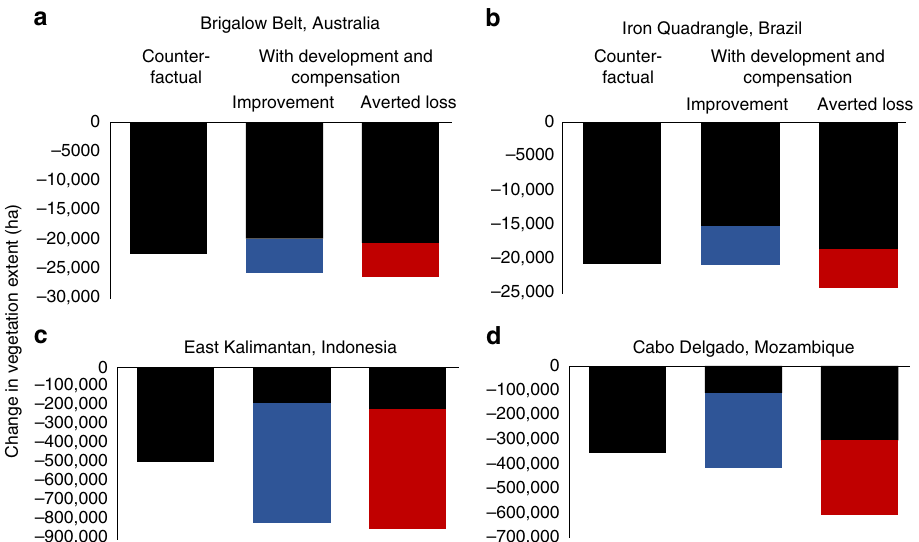
Fig. 4 Change in native vegetation under our counterfactual scenario (without regulated development and its required compensation) and the best performing Averted Loss and Improvement policy designs (Fig. 2). Unregulated biodiversity losses are shown in black and net biodiversity losses due to regulated development (i.e. regulated losses minus compensation gains) are shown in red (for Averted Loss) and blue (for Improvement). Panels represent four case studies: a Brigalow Belt, Australia; b Iron Quadrangle, Brazil; c East Kalimantan, Indonesia; d Cabo Delgado,